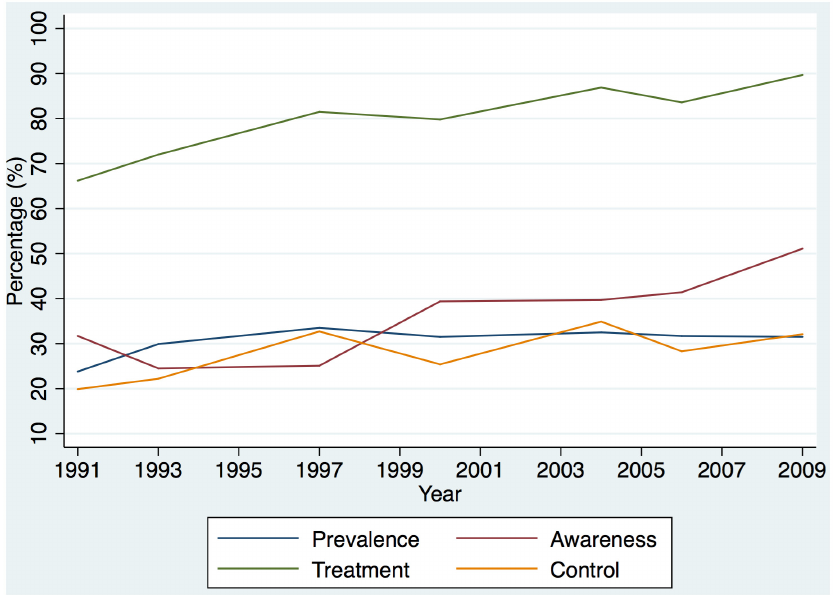
Fig 2. Trends in prevalence, awareness, treatment and control of